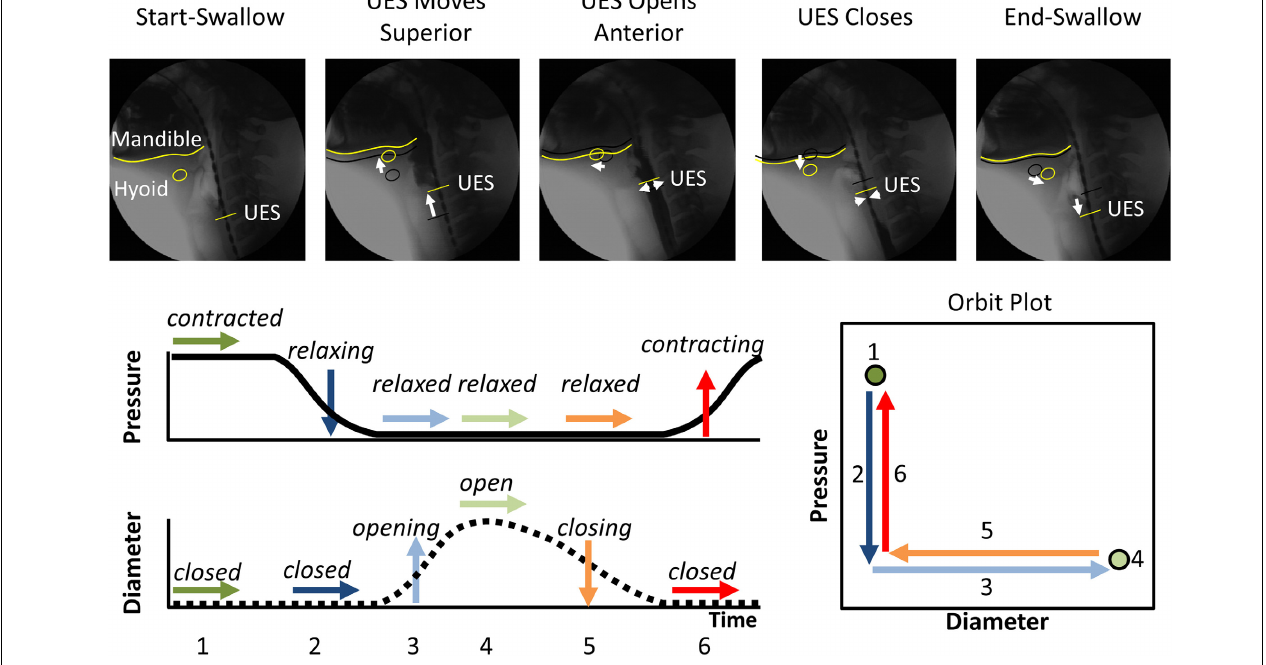
FIGURE 1 | The typical pattern of pressure and diameter change that the UES undergoes during normal swallowing. Videofluoroscopy images show the different phases of swallow. The position of the inferior edge of the mandible, the hyoid bone and the UES proximal margin are outlined in yellow in each frame. White arrows show movement of the relevant anatomical structures relative to their position from previous frame (shown as black shadow). A typical UES pressure profile is shown with arrows indicating periods when pressure is static ( → ), decreasing ( ↓ ) or increasing ( ↑ ). A typical diameter profile is shown with arrows